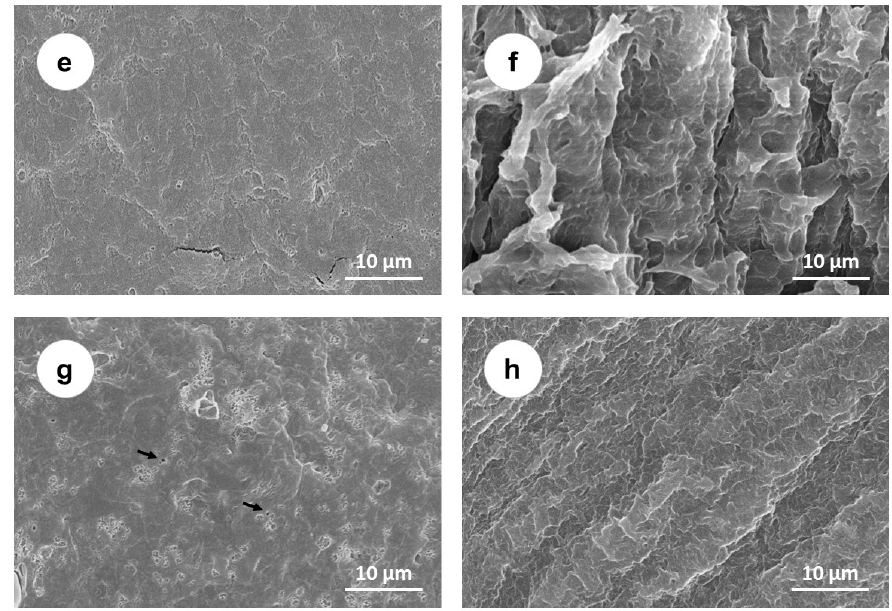
Figure 1. SEM micrographs of PVA, PVA/PAA, PVA/PAA+PEG, and PVA/PAA+PEG + A samples: surface morphology ( a , c , e , g , respectively) and cross-cut section ( b , d , f , h , respectively) (scale bar: 10 µm). Arrows show examples of pore-like clusters.